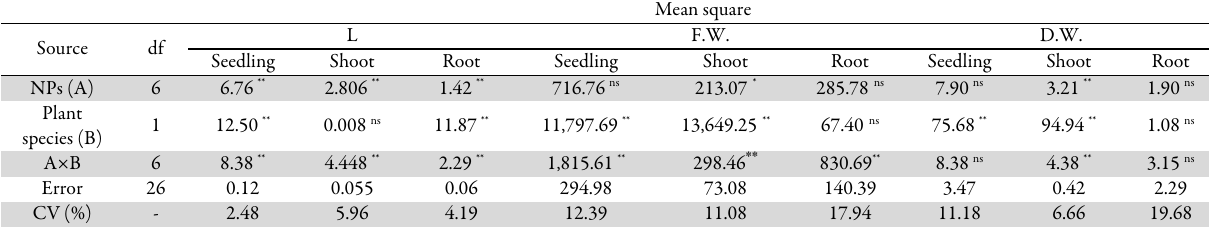
Table 3. Analysis of variance for some growth parameters of barley and wheat Source